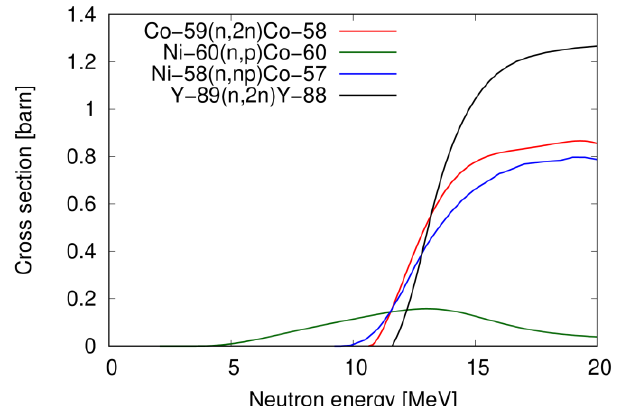
Fig. 5 Cross sections for neutron reactions with high threshold energies. The reaction Ni-58(n,np)Co-57 cross section is taken from the JEFF-3.3 nuclear data library while other cross sections are taken from the IRDFF-II nuclear data